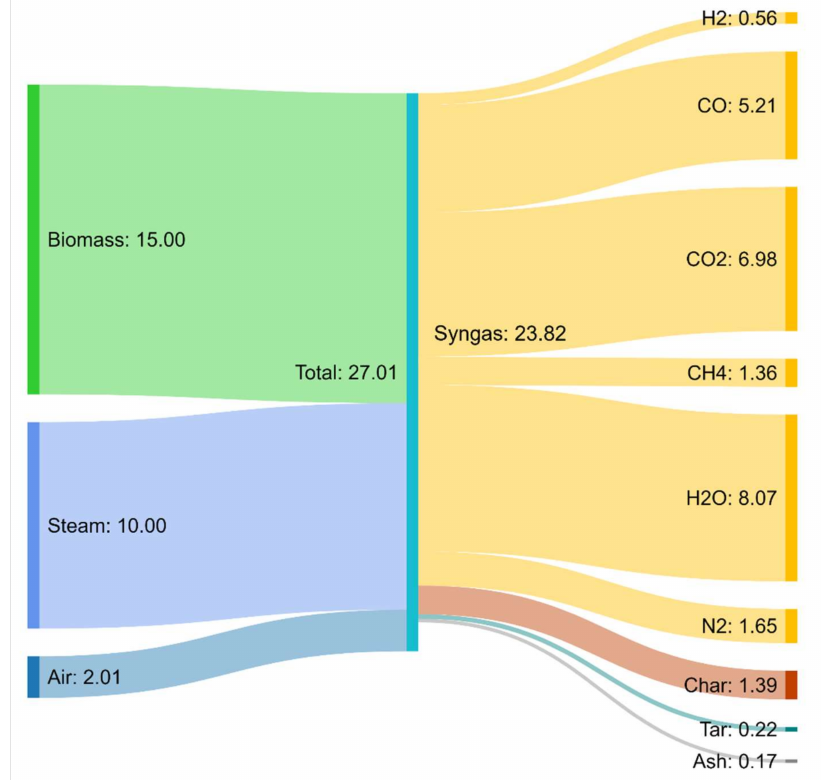
Figure 8. Gasifier mass balance (units in kg/h).